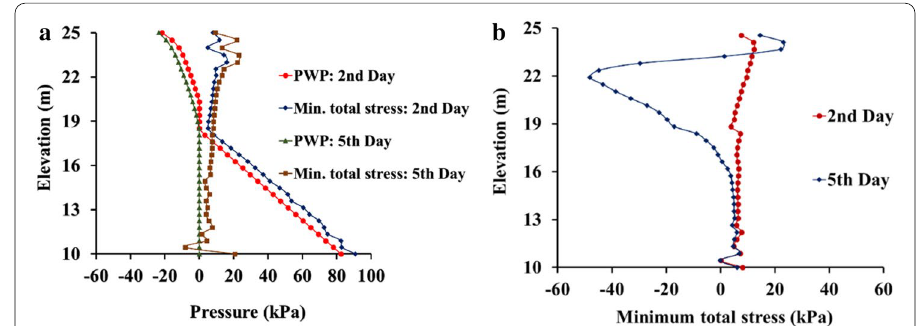
Fig. 20 Comparison of total minor principal stress with the developed PWP to identify the possible location of hydraulic fracturing pertaining to reservoir drawdown operation initiated after the steady-state phreatic surface is attained a upstream face, b downstream